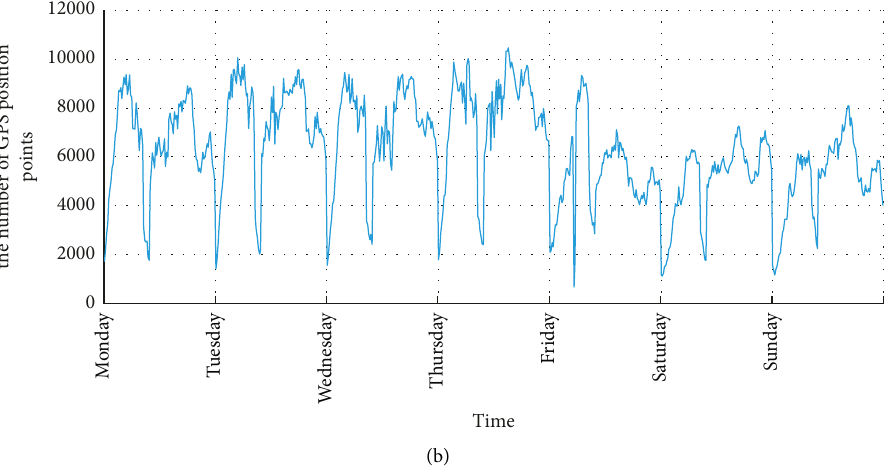
Figure 5: The variation trend of each attribute information of all grids. (a) The variation trend of the number of vehicles and the average speed. (b) The variation trend of the number of GPS position